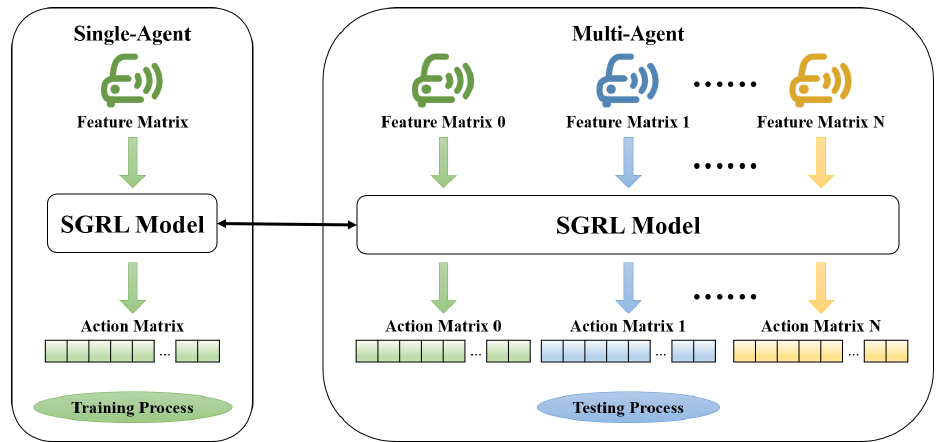
Figure 7. Reinforcement learning model transplant